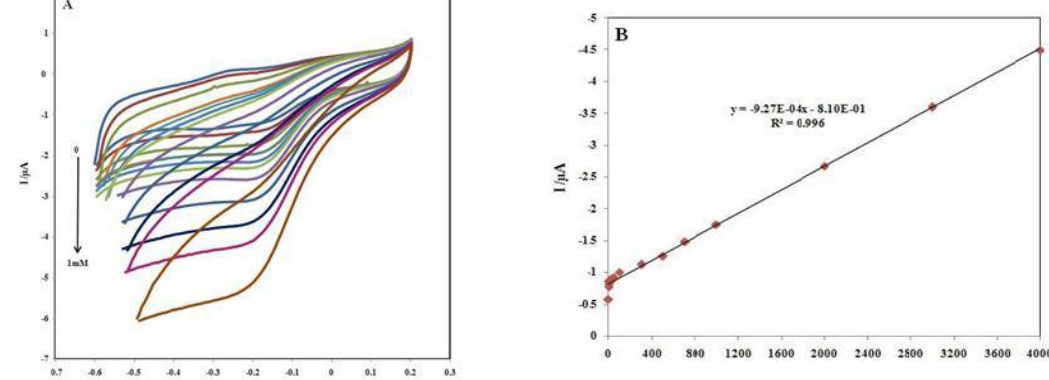
Fig. 5. (A) CVs of a Cyt c on a nafion-rGO/GC electrode in a set of H 100, 300,500, 700, 1000µM).(B) Linear calibration curve for